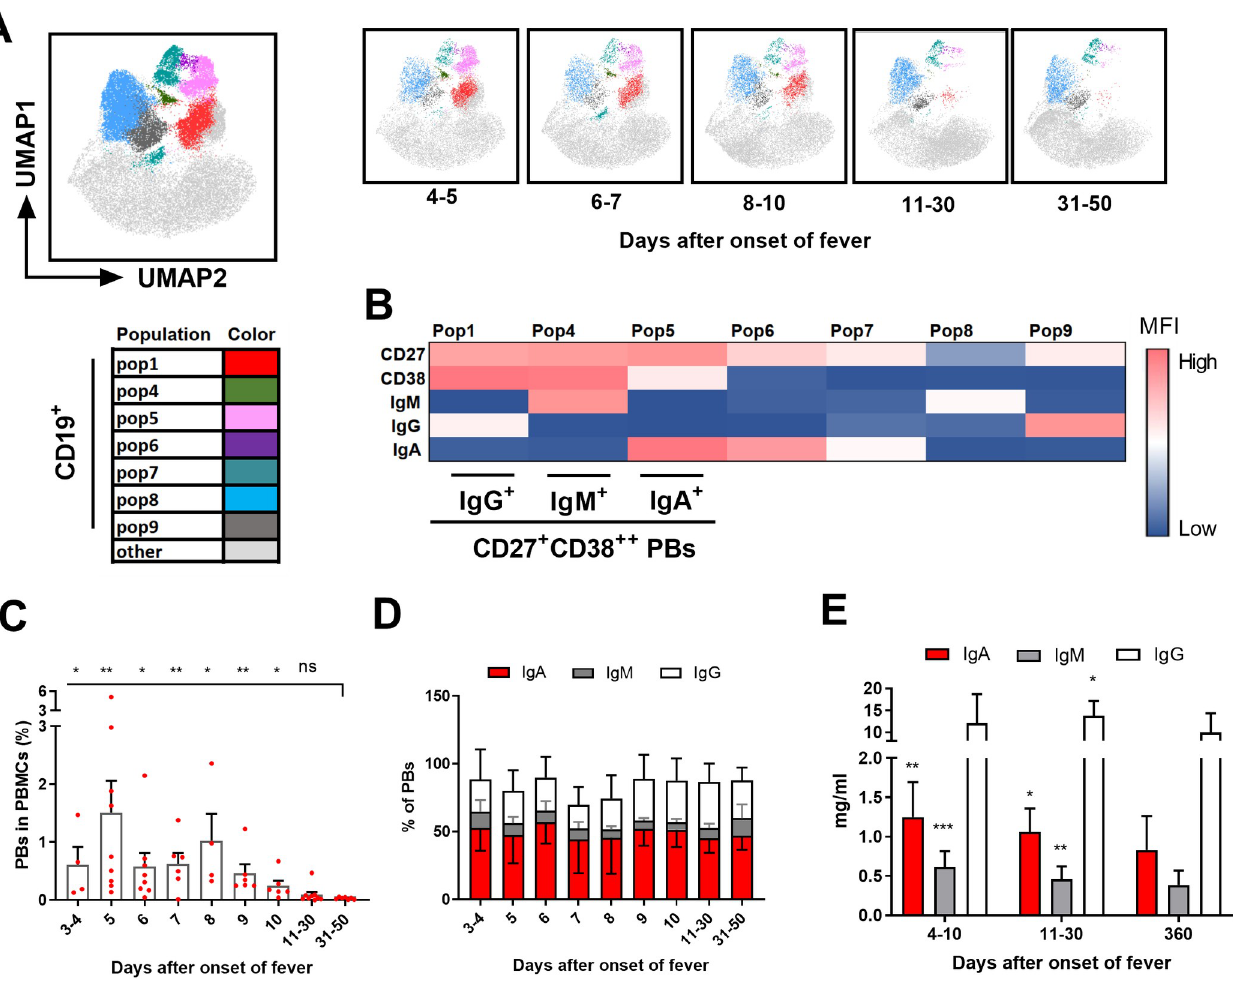
Fig 5. Plasmablast frequencies increase in the circulation of patients with acute PUUV-HFRS. A ) UMAP and FlowSOM analysis was used to identify different cell populations in single live PBMCs, from which CD3, CD14, CD56 and CD66 positive cells were removed by conventional gating (gating strategy shown in S2 Fig). The distinct CD19 + cell populations are shown by specific colors, whereas the CD19 - populations are merged as light grey color in the plot. ( B ) Heatmap showing the relative mean MFI of CD27, CD38, IgM, IgG and IgA in different CD19 + cell populations. ( C ) The frequencies of CD19 + PBs out of total number PBMC used for flow cytometry analysis (gating shown in S2 Fig) were calculated for each sample at indicated days post onset of fever. Data is obtained from 13 PUUV-HFRS patients. ( D ) The frequencies IgA + , IgM + and IgG + PBs in relation to the total number of PBs for each sample were calculated and plotted similarly as in C . ( E ) EDTA-plasma from acute (1 st day of hospitalization, 5–8 days post onset of symptoms), early recovery (15–30 days post onset of symptoms) and full recovery (180 days post onset of symptoms) were subjected to total IgA, IgM and IgG ELISA (n = 14 for all groups). Significant differences between each indicated time point to full recovery (31–50 days post onset of symptoms in C and 180 days post onset of symptoms in E ) were calculated using generalized estimating equations. � p < 0.05, �� p < 0.01, ��� p < 0.001. PUUV-HFRS (Fig 5A). Based on cell surface expression of CD27 and CD38 markers, as well as intracellular Ig isotype expression, three populations were identified as PBs (pop1 = IgG + PBs, pop4 = IgM + PBs and pop5 = IgA + PBs), whereas the other four populations probably repre- sented na ï ve and memory B cell subsets (Fig 5B). Next the abundance of CD19 + /CD27 + / CD38 +++ PBs (S5 Fig shows the gating strategy for representative acute and recovery phase samples) was normalized to the total number of PBMCs in the sample (Fig 5C). We observed a significant expansion of PBs in the acute stage (4–10 days aof) as compared to the samples drawn at recovery (at 31–50 days aof). The median frequency of PBs fluctuated extensively during the acute stage from 0.5% to 1.5% of all PBMCs. These findings indicate a marked B